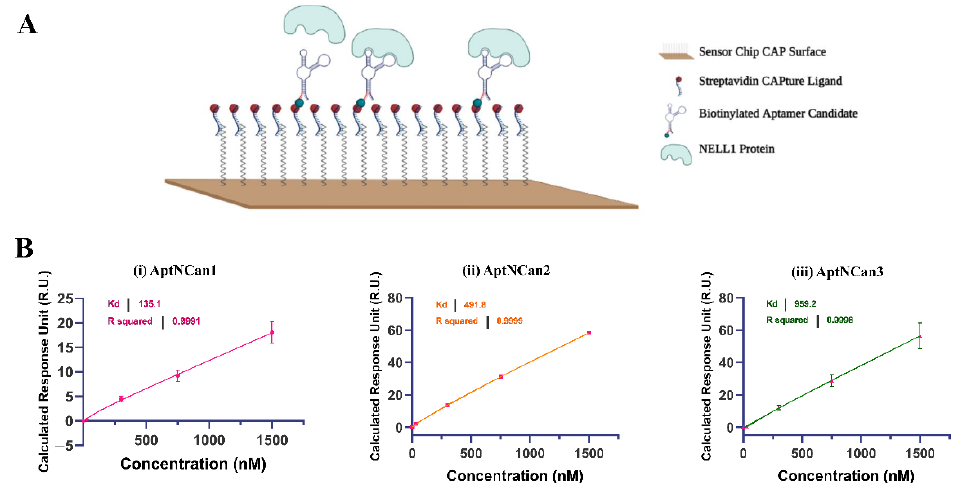
Figure 4. Quantification of the binding between NELL1 protein and aptamer candidates. ( A ) Illus- tration of the principle of using Biacore CAP microfluidic chip for the quantification of anti-NELL1 aptamer candidate to the NELL1 protein analyte. Modified from Laboratory Guideline Biacore System, 28-9615-80 AB, 11/2011, GE Healthcare Bio-Sciences AB. www.gelifesciences.com/biacore. Accessed on 10 January 2022 ( B ) Representative quantification of Kd binding affinity of different aptamer candidates fitted from the SPR binding data. Data are presented as mean ± SD for each individual candidate binding ( n = 3).